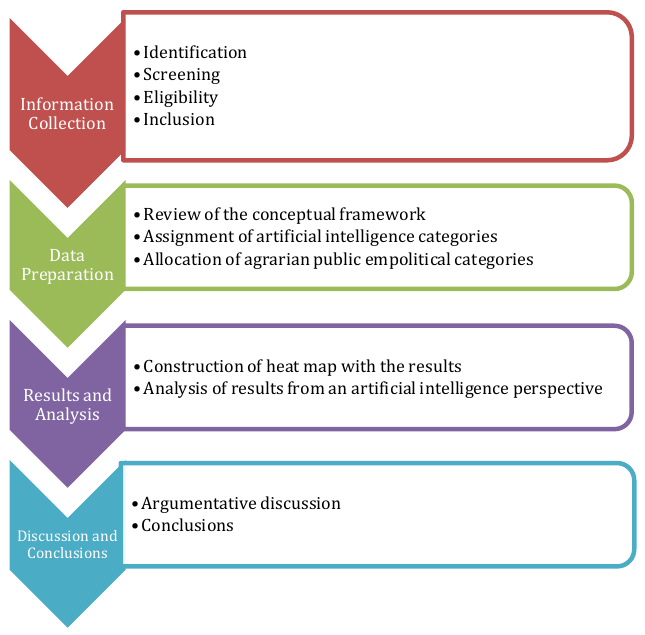
Figure 1. Methodological